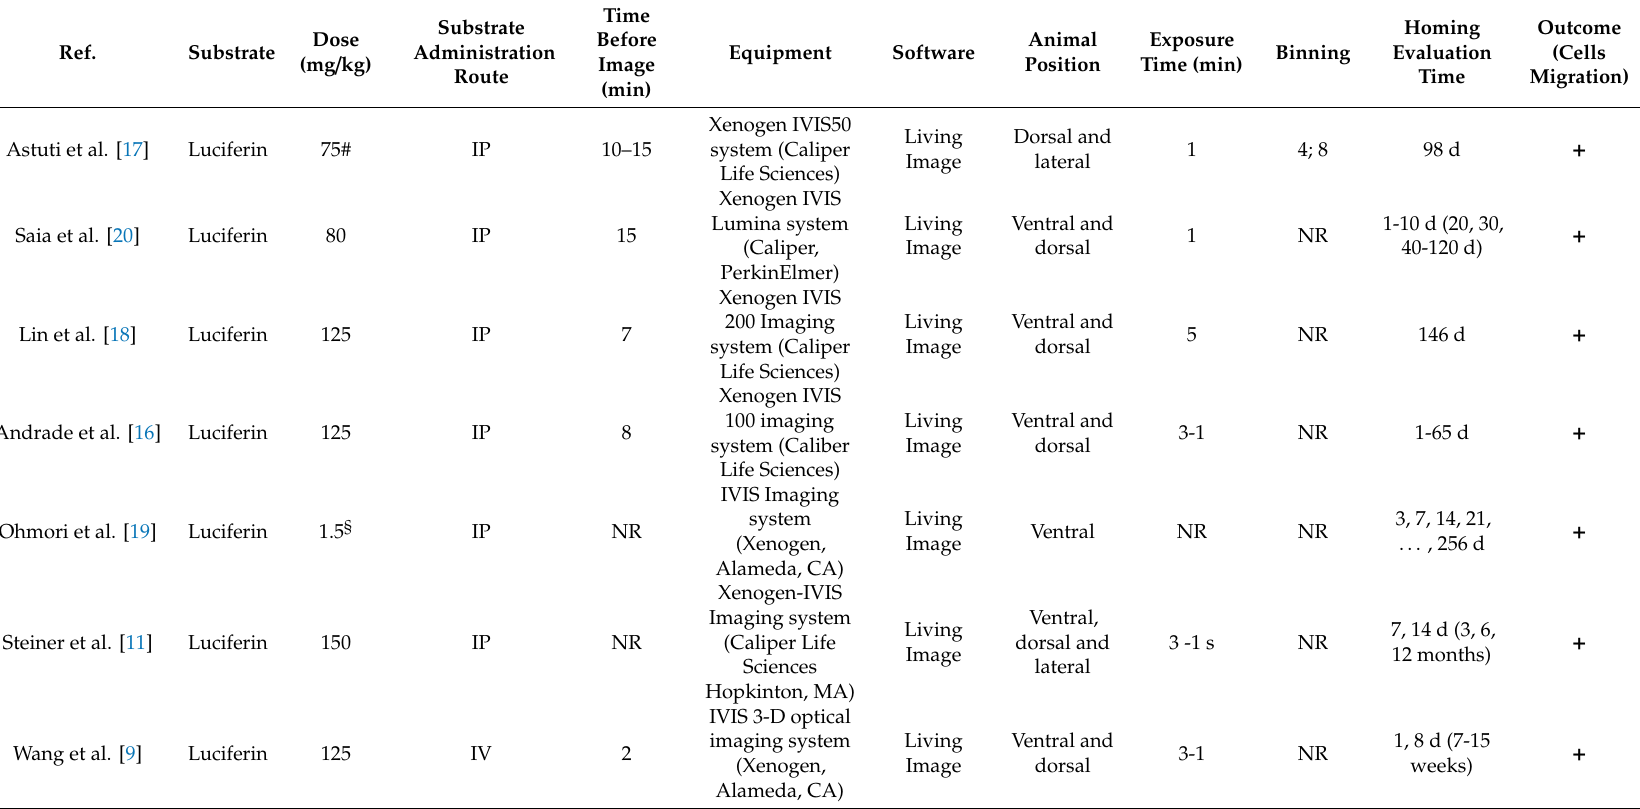
Table 7. HSCs migration homing and tracking by